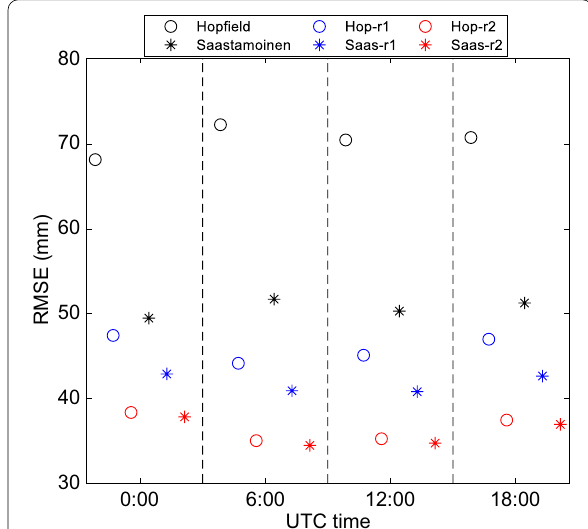
Fig. 8 The performance of the six models at different UTC